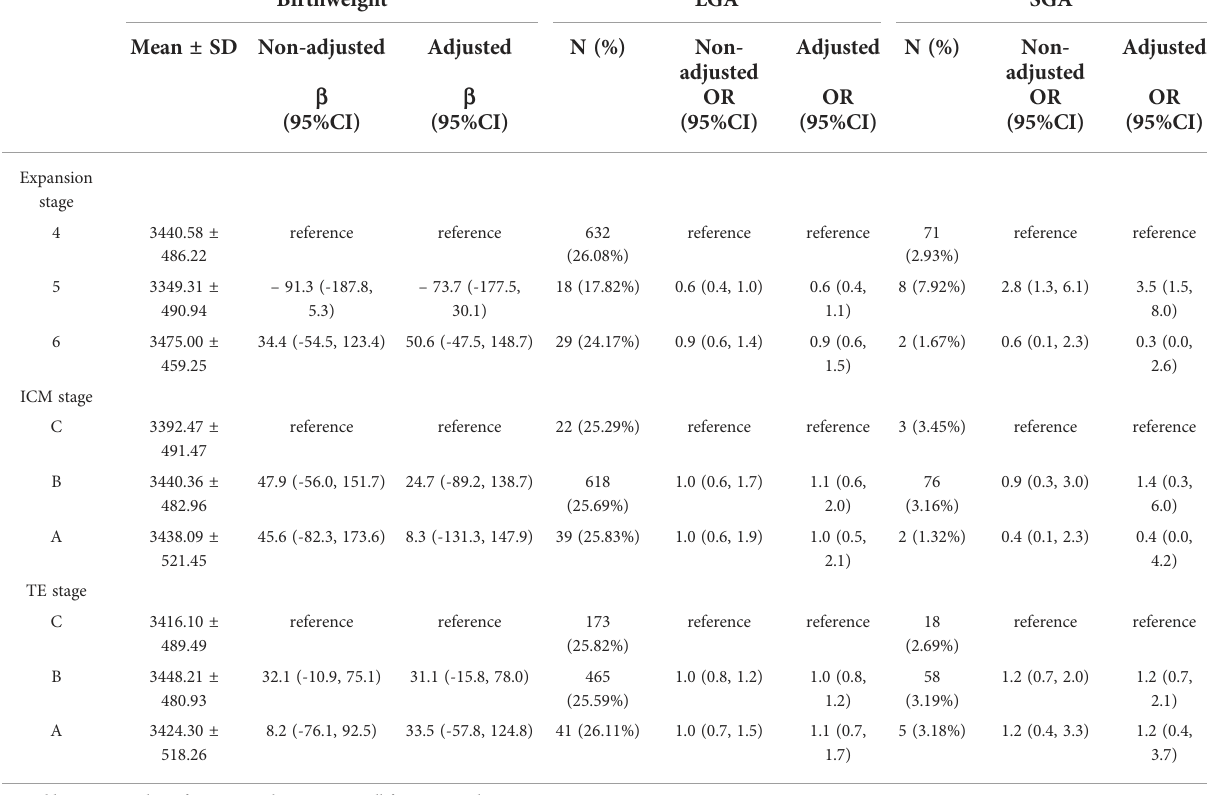
OR, odds ratio; LGA, large for gestational age; SGA, small for gestational age. Data are expressed with mean ± SD or number (percent) as